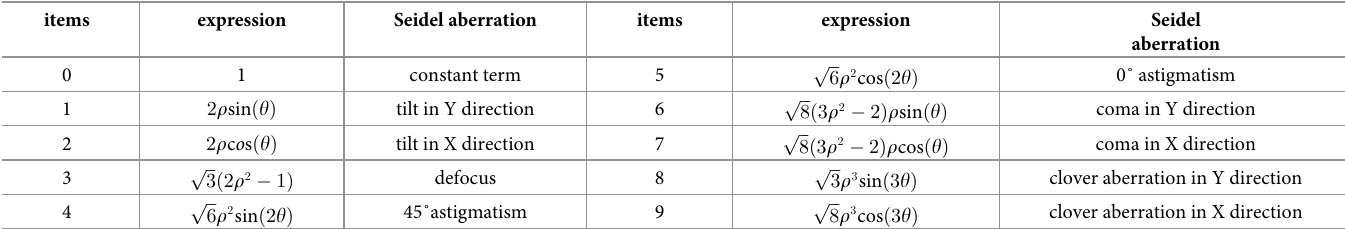
Table 1. Zernike expression and its corresponding Seidel